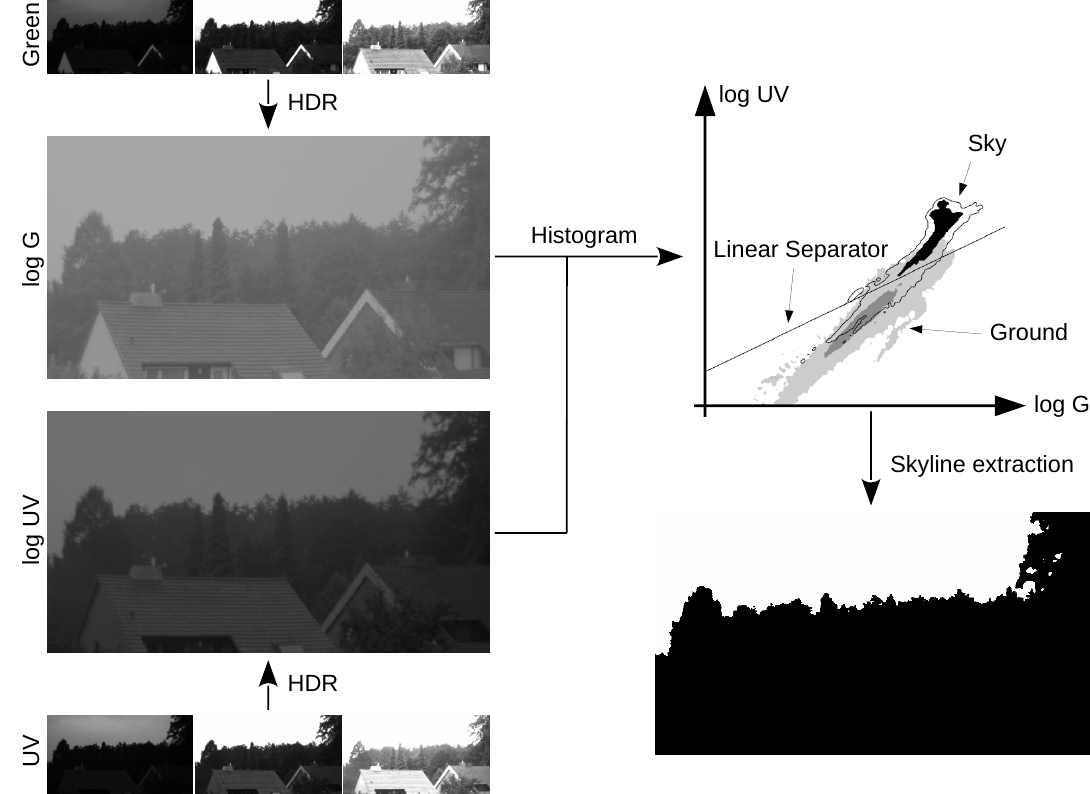
Figure 2. Overview of the different processing steps: For each channel (UV and green) the raw input images with varying exposure times (left, small images) are combined into HDR images (left, large images). Afterwards, a 2D histogram is built (right, top), showing the distribution of the log UV and log G values for each pixel of either a database of multiple image pairs (“global” methods) or of a single image pair (“local” methods). Finally, a linear separator is used to classify each pixel as either ground or sky, providing an image of the skyline (right, bottom) which is widely illumination